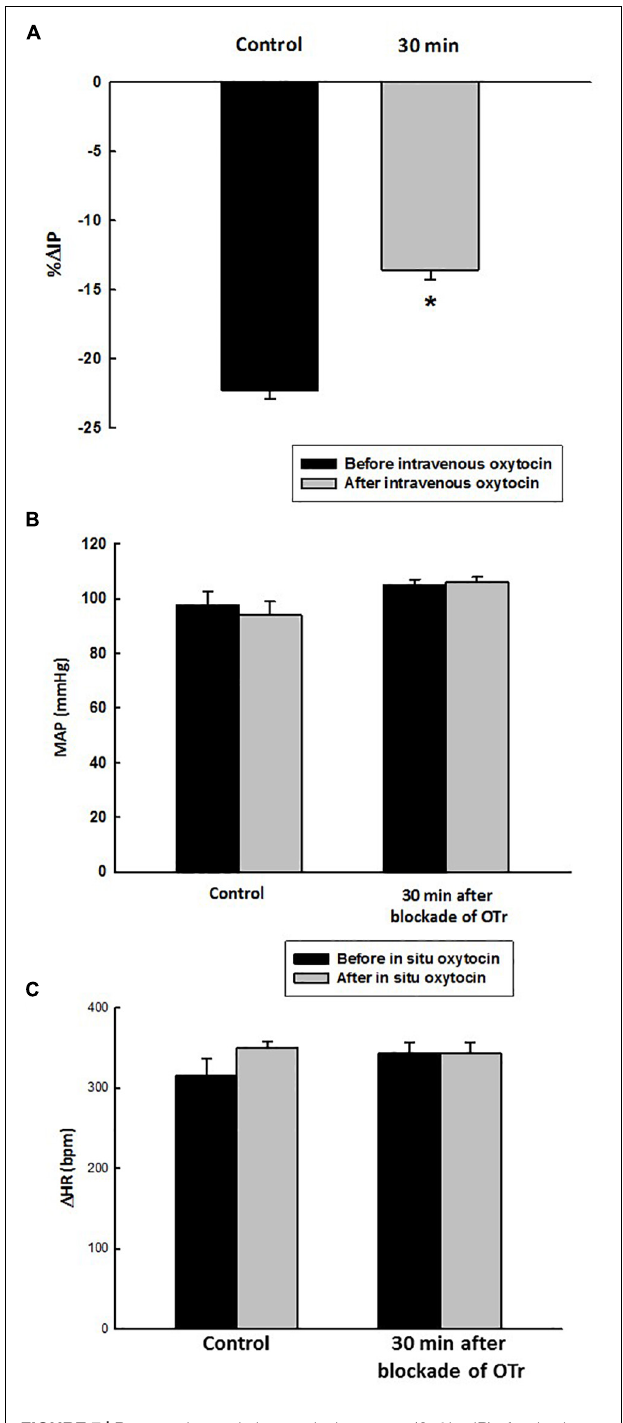
FIGURE 7 | Percent change in intravesical pressure ( A , % (cid:49) IP) after in situ administration of 0.1 mL of saline (vehicle) or oxytocin (0.1 ng/rat) ( N = 7) at 35 min after blockade of oxytocin receptors (10 ug/kg, i.v.) in intact rats. Mean arterial pressure ( B , MAP, mmHg) and heart rate ( C , HR, bpm) at baseline and after in situ administration of 0.1 mL of saline (vehicle) or oxytocin dose (0.1 ug/rat mL) at 35 min after blockade of oxytocin receptors (OTr) (10 ug/kg, i.v.) in sham rats, * p < 0.05 vs. control ( N =